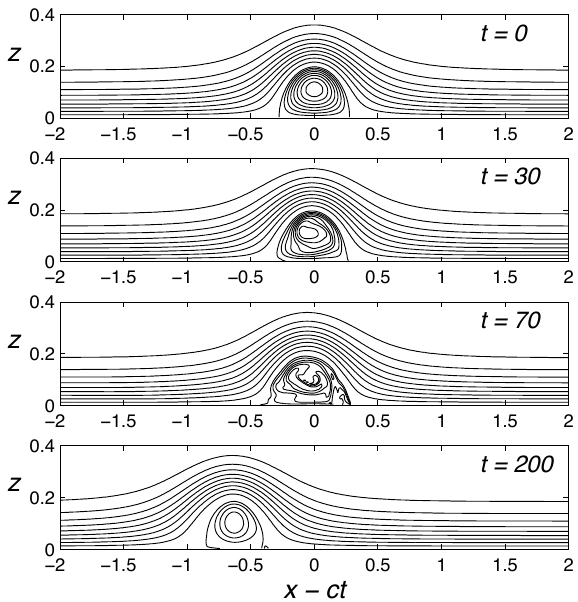
Fig. 2. Evolution of an extended- ¯ s DJL solution for λ =8 and c = 0 . 4. Contours of s in intervals of 0.1 for s ≤ 1 (outside the core) and 0 . 025 for s> 1 (inside the core) are plotted. Times are indicated in the panels. Note that only part of the domain is shown.